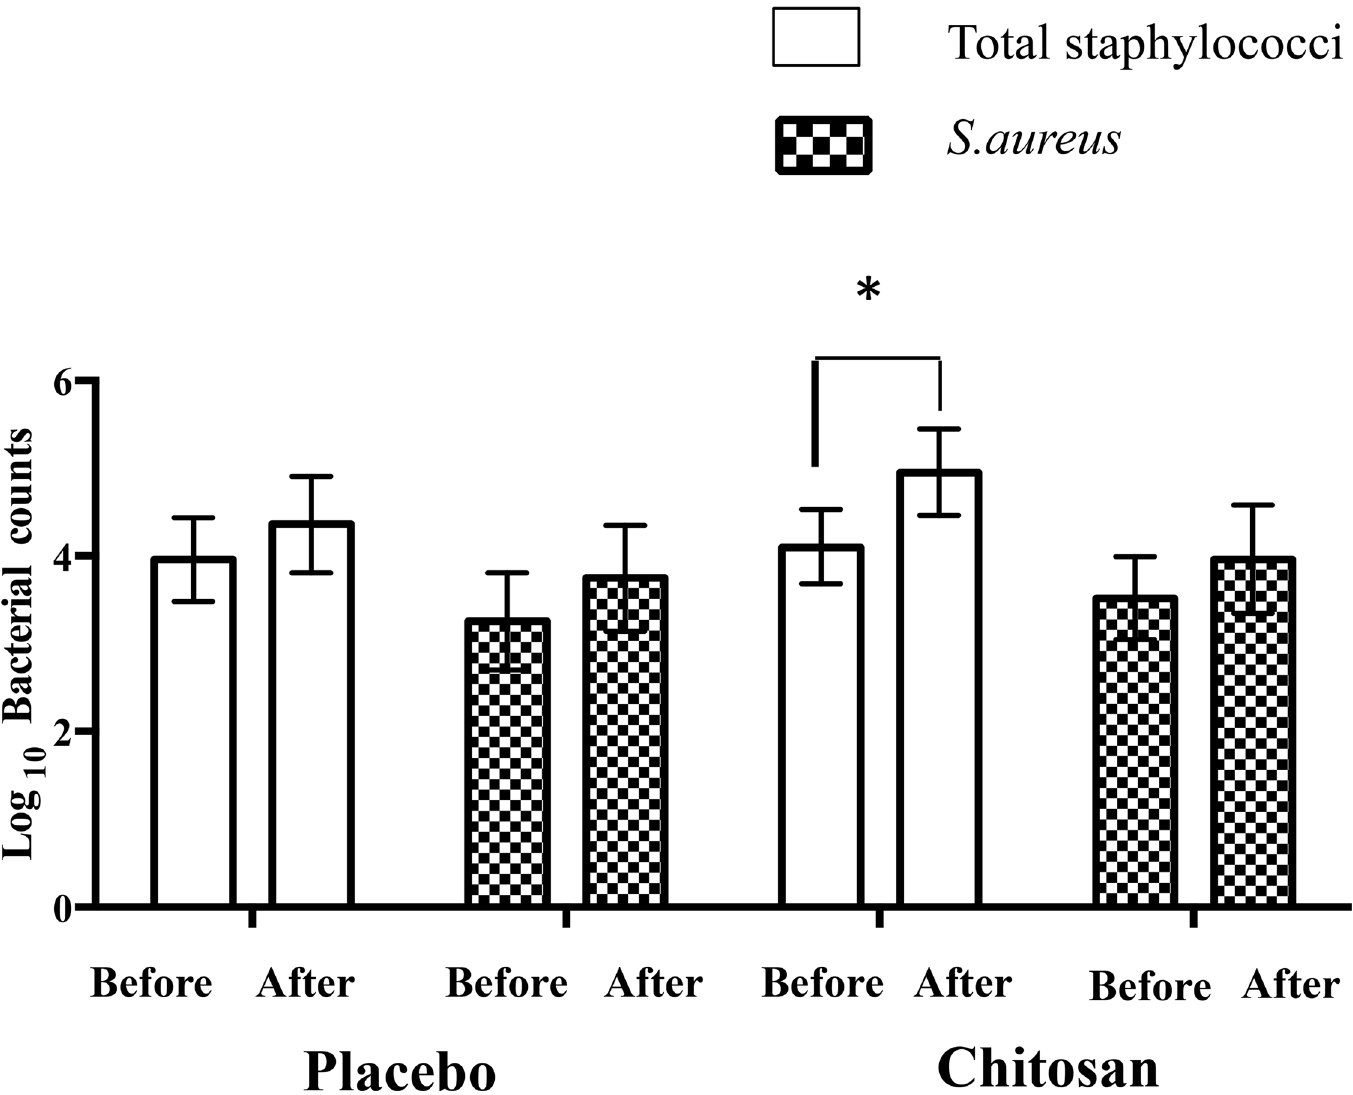
Fig 5. Mean (95% CI) Log10 total staphylococci and Log10 Staphylococcus aureus counts for all regions sampled in chitosan and placebo groups before and after intervention. CI-confidence interval * P = 0.01, Wilcoxon signed rank